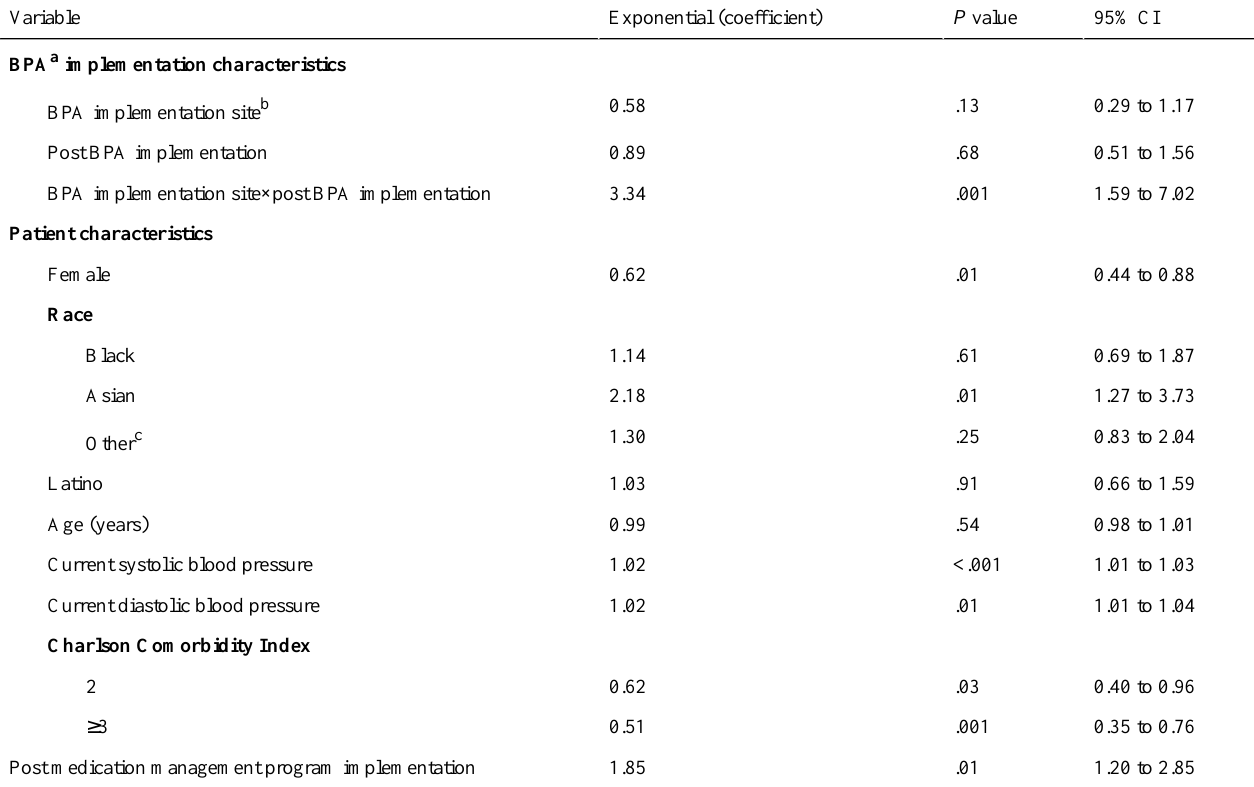
Table 3. A mixed effects logistic regression analysis on angiotensin-converting enzyme inhibitor or angiotensin-receptor blocker prescribing in response to opportunity encounters.